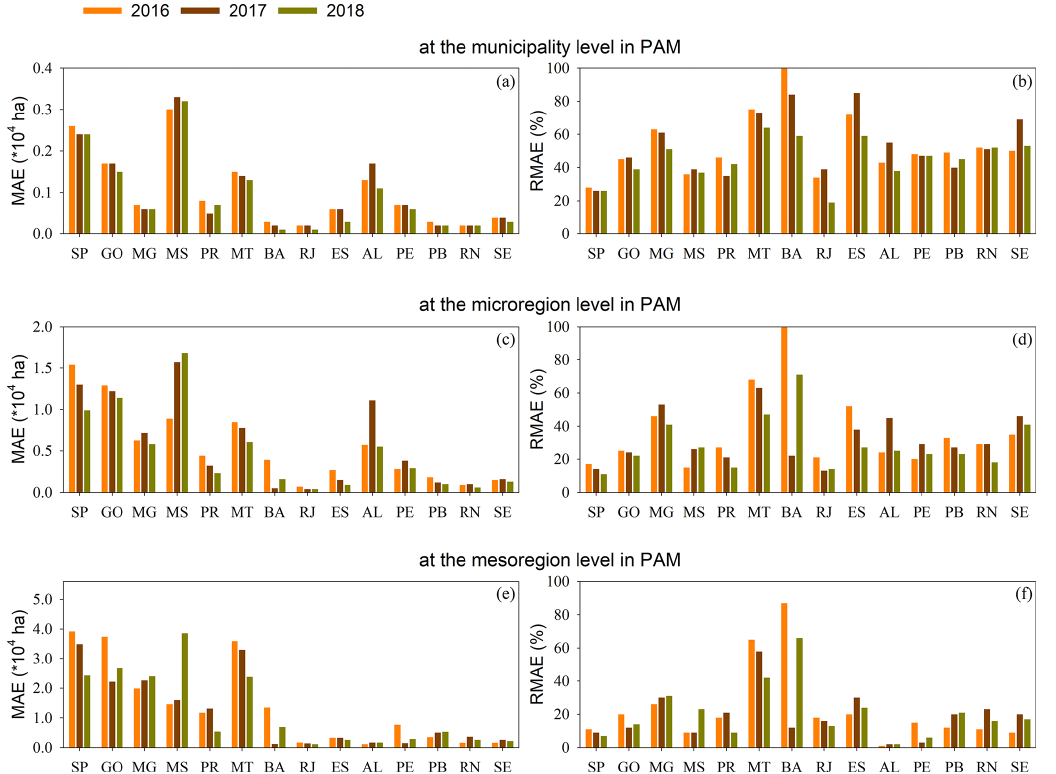
Figure 13. Comparisons between the agricultural statistical harvest area and the estimated harvest area of sugarcane (MAE and RMAE) at